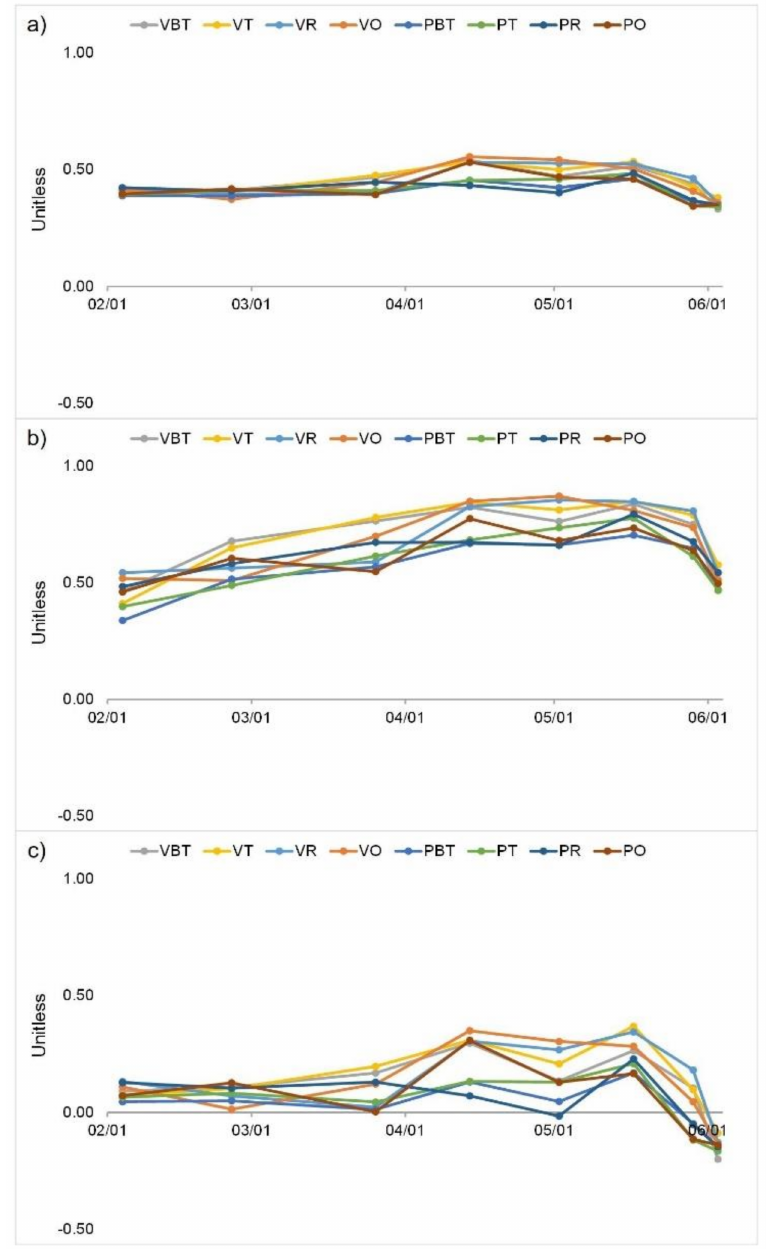
Figure 4. Temporal evolution of ( a ) Gr, ( b ) NDVI and ( c ) GRVI for the eight